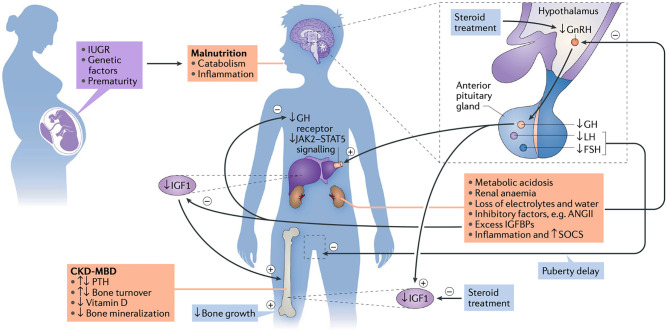
The etiology of growth failure in CKD is multifactorial and includes intrauterine growth restriction (IUGR), genetic factors, such as parental height and primary kidney disease, prematurity and malnutrition which especially limits growth in children with congenital CKD. Mineral and bone disorder (CKD-MBD), metabolic acidosis, anemia, loss of electrolytes and water, and disturbances of the somatotropic and gonadotropic hormone axes are additional factors. CKD is a state of growth hormone (GH) insensitivity, characterized by a deficiency of functional insulin-like growth factor I (IGF-I), reducing GH receptor expression in target organs like the liver, disturbed GH receptor signaling via the Janus kinase signal transducers, activators of transcription (JAK2-STAT5) due to inflammation-induced SOCS (suppressor of cytokine signaling), and increased IGF-binding capacity due to excess of IGFBPs. Finally, reduced release of hypothalamic gonadotropin-releasing hormone (GnRH), due to uremia-related inhibitory factors such as angiotensin II (AngII) and steroid treatment, may result in decreased circulating levels of bioactive luteinizing hormone (LH), hypogonadism and reduced pubertal growth spurt (13). PTH, parathyroid hormone; FSH, follicle stimulating hormone; IGFBP, insulin-like growth factor binding proteins. Figure and figure legend taken from (13).